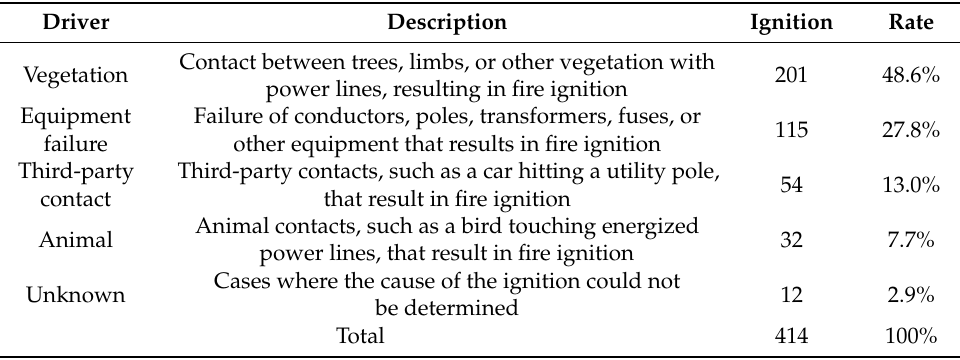
Table 1. Fire ignition drivers of the utility company (PG&E) from 2015 to